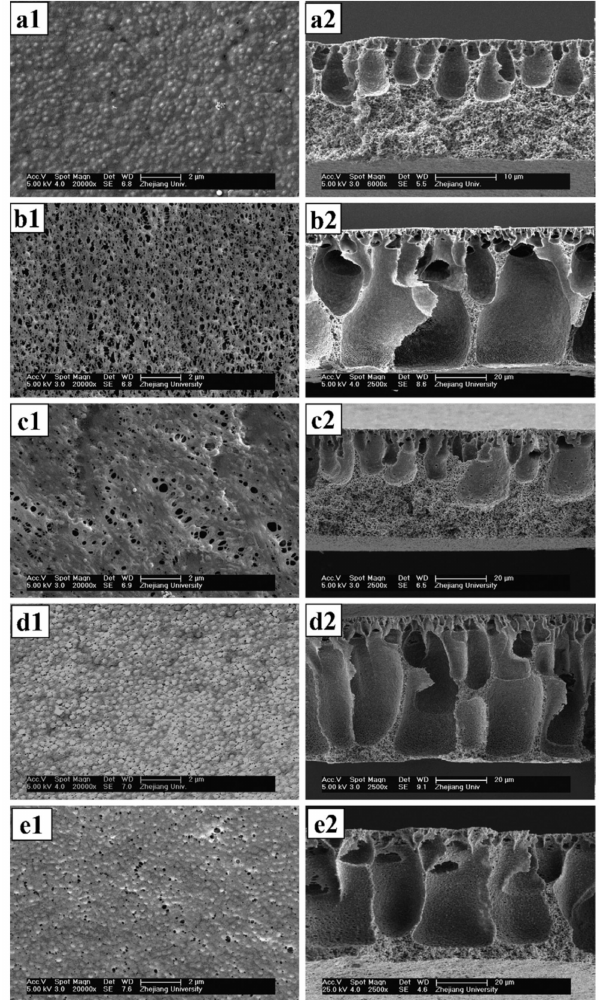
Figure 2. SEM images of top surface (left) and cross-section (right) of the membranes. ( a1 , a2 ) Pure PVDF, ( b1 , b2 ) PVDF/EPTBP, ( c1 , c2 ) PVDF/ACPS, ( d1 , d2 ) PVDF/HPE-g-MPEG and ( e1 , e2 )